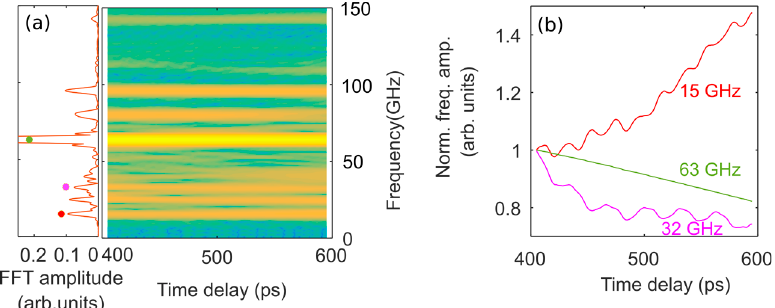
Figure 8. ( a ) Left: FFT amplitude of the acoustic signal in the time interval from 400 ps to 800 ps for the pump power of 67 mW. Right: short time FFT analysis by using a long moving window length. ( b ) Dependences on time of 15 GHz, 32 GHz and 63 GHz mode amplitudes, which are obtained from short time FFT image (see right-hand figure of ( a )).